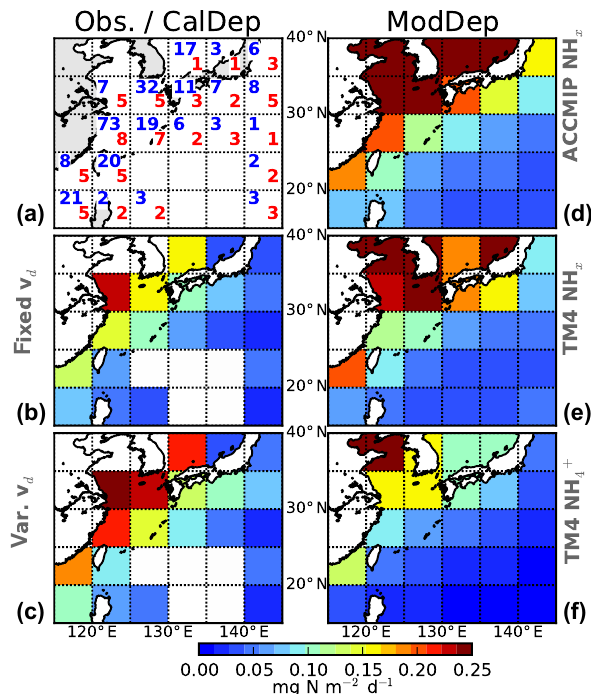
Figure 13. Dry deposition fluxes (mg Nm − 2 d − 1 ) for NH + for the NWPac region. Panels are as described in Fig.